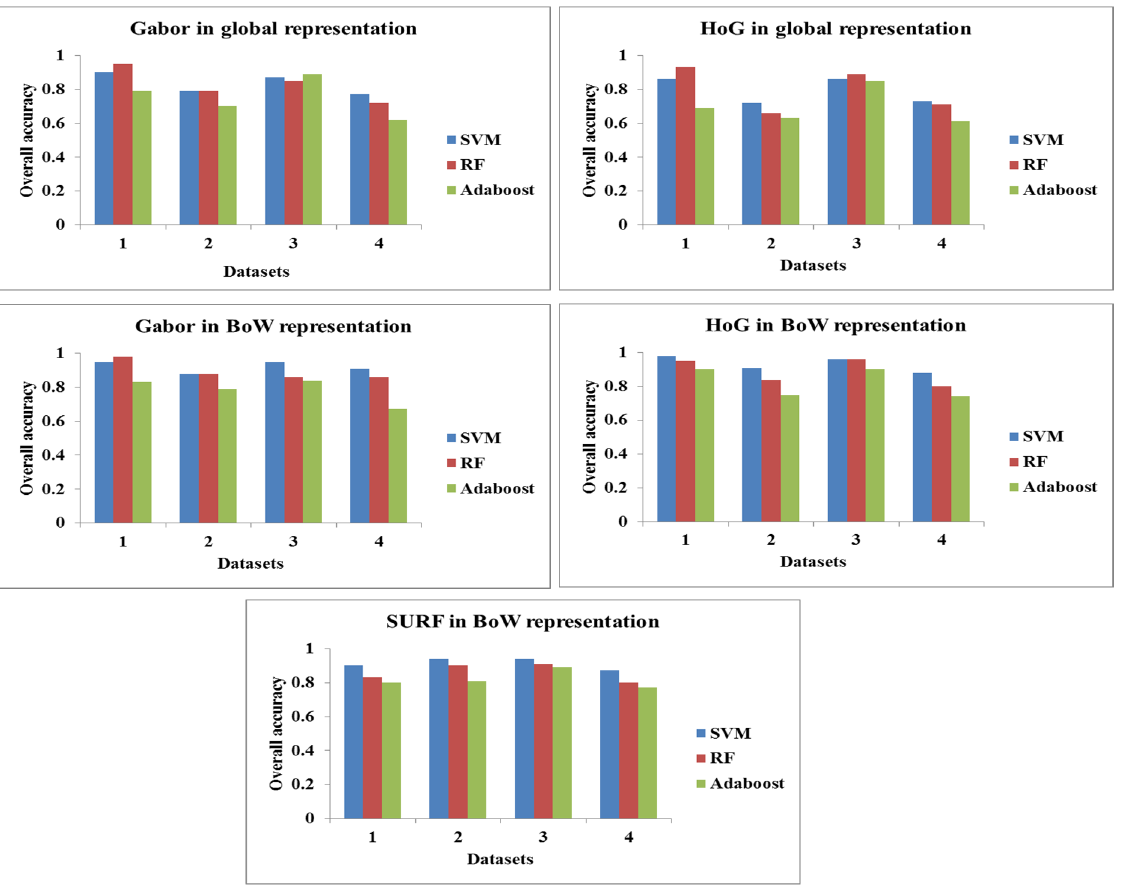
Figure 10. The accuracy produced by the feature descriptors for each dataset when associated with different classifiers.